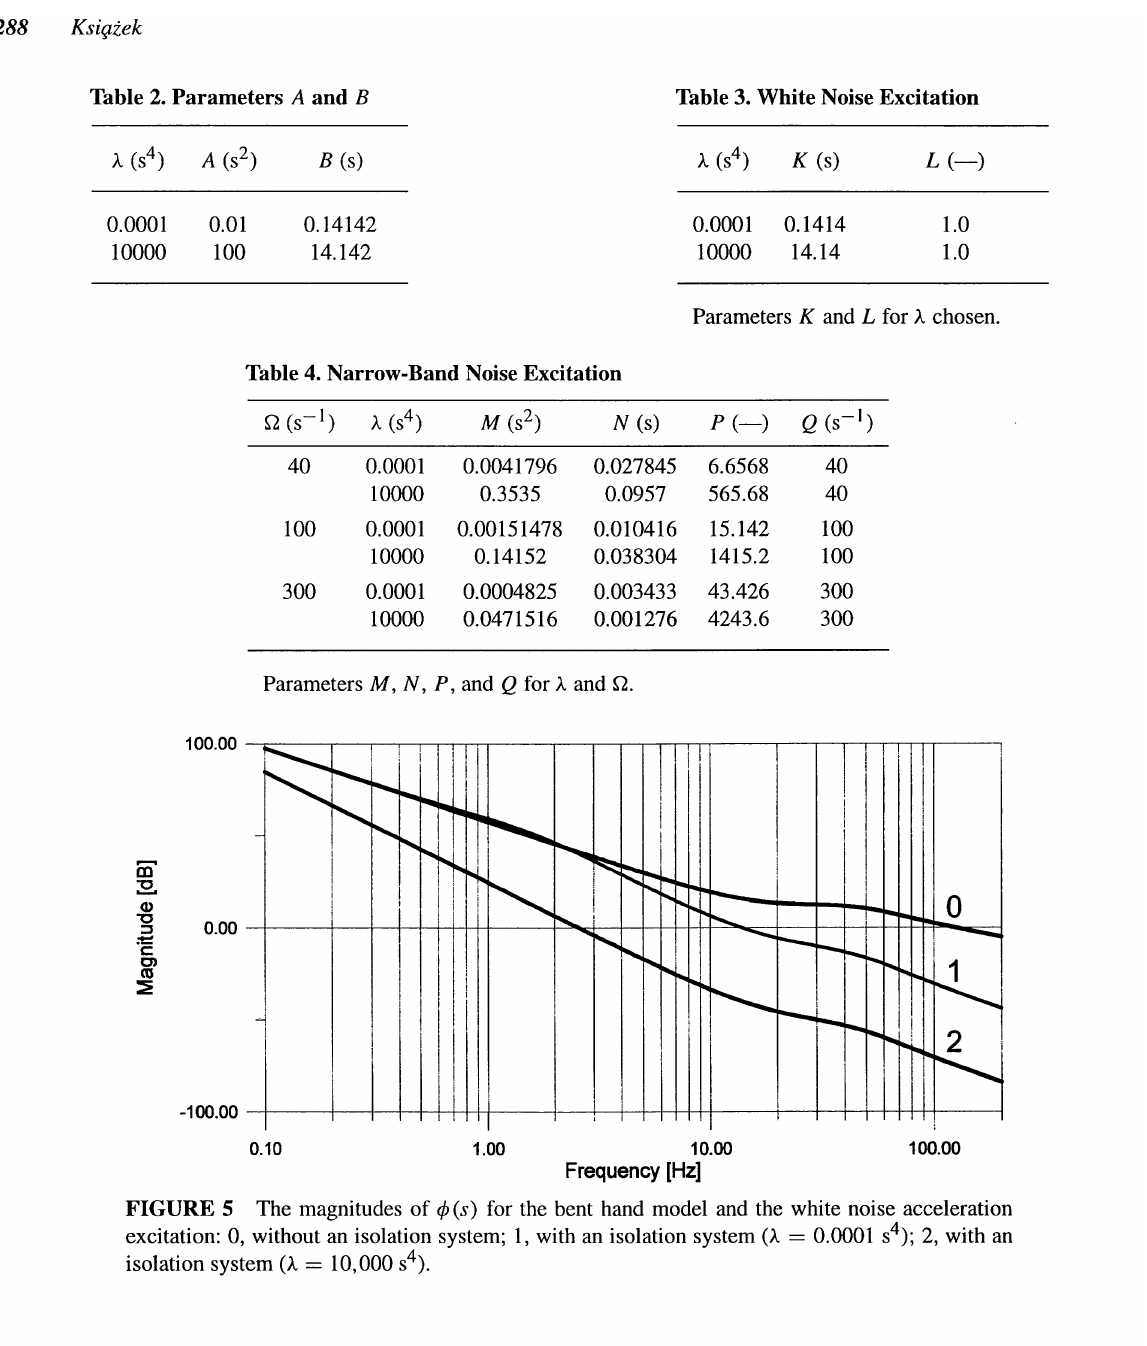
Table 2. Parameters A and B Table 3. White Noise Excitation